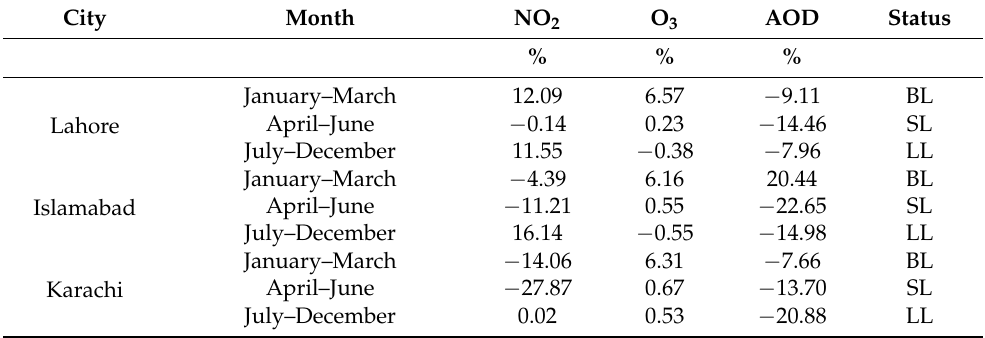
Table 6. Percentage changes in NO 2 , O 3 , and AOD concentrations when comparing the 2020 lockdown period to the same period in 2016–2019 across the three metropolitan cities of